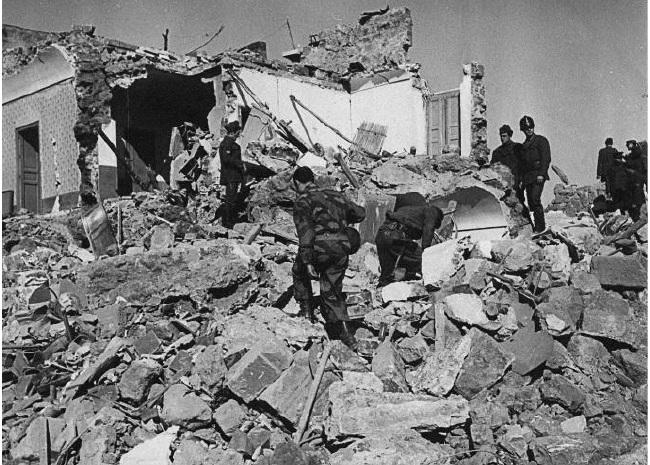
Figure 5. Montevago after the earthquake. Photo: Archivio de L’Ora, Biblioteca Regionale Siciliana “Alberto Bombace”, Palermo.